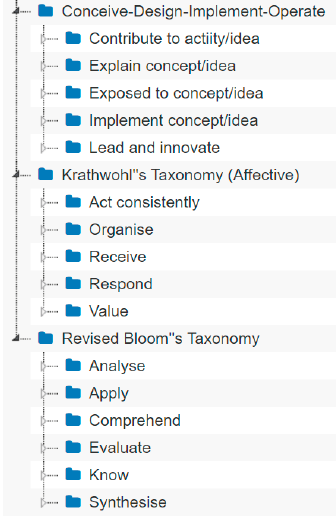
Figure 4. Part of an “attainment” taxonomy for building ILOs.